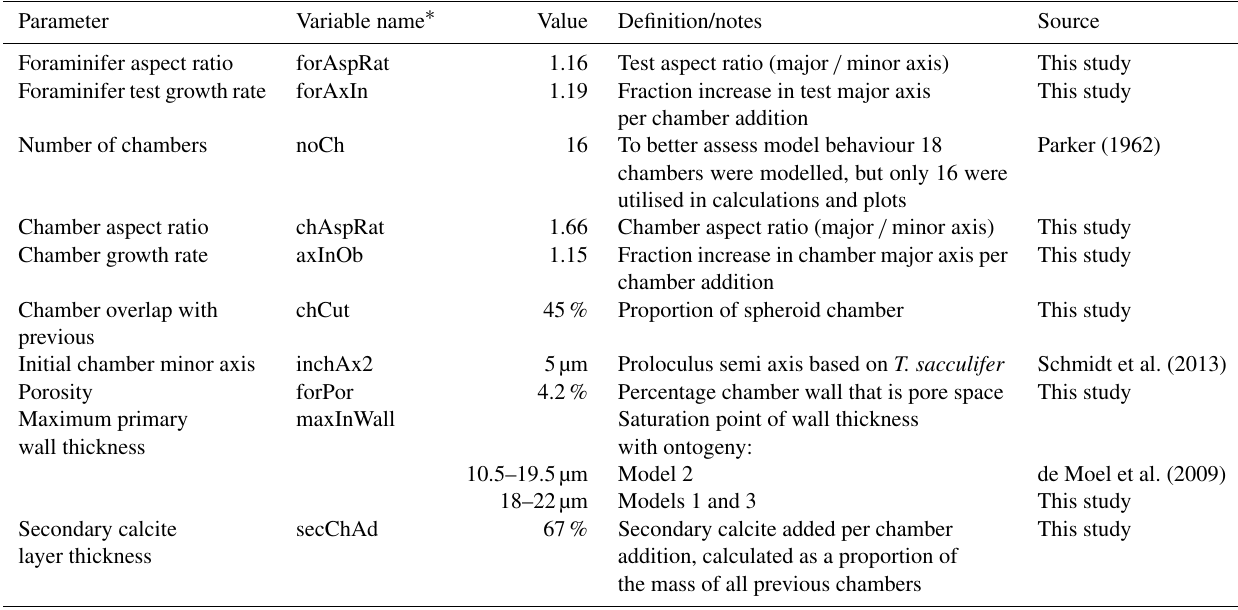
Table 2. Observational constraints on G. ruber morphology used to construct the